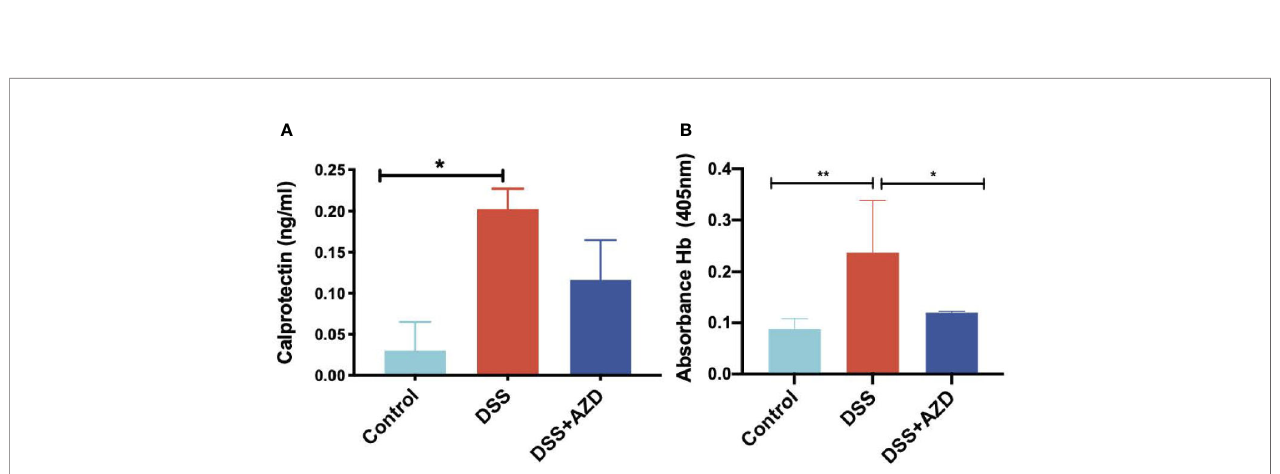
FIGURE 6 | Quanti fi cation of fecal calprotectin (A) with (ELISA as described in methods section and fecal Hb (B) in fecal homogenates using Tecan M200 Pro at 405 nm wavelength. Mice were randomly divided into three treatment arms over 9 days i) vehicle group (n = 5) given normal drinking water and peanut butter without drug; ii) DSS group (n = 5) given 2% w/v dextran sodium sulfate (DSS) in drinking water and peanut butter without drug; iii) DSS+AZD3241 (n = 5) given 2% w/v DSS in drinking water and AZD3241 @ 30 mg/kg in peanut butter. Snap frozen fecal samples in liquid nitrogen were grounded into a fi ne powder using a mortar and pestle, transferred into a glass vial and then treated with 1 ml complete lysis buffer as described in methods section, centrifuged and supernatant separated for subsequent analyses. *Different to the control (6A), (p = 0.04); *Different to the control, (p = 0.02) and **different to DSS+AZD3241, (p = 0.005) (6B). Note, AZD3241 is abbreviated to AZD in this fi